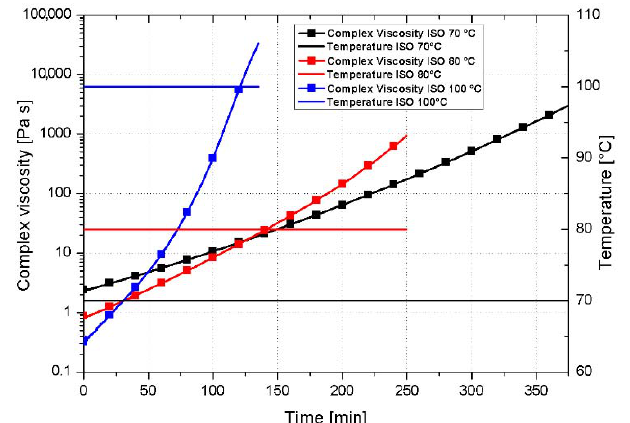
Figure 10. Isothermal rheological tests for the system loaded with 5 wt% of AHBP.